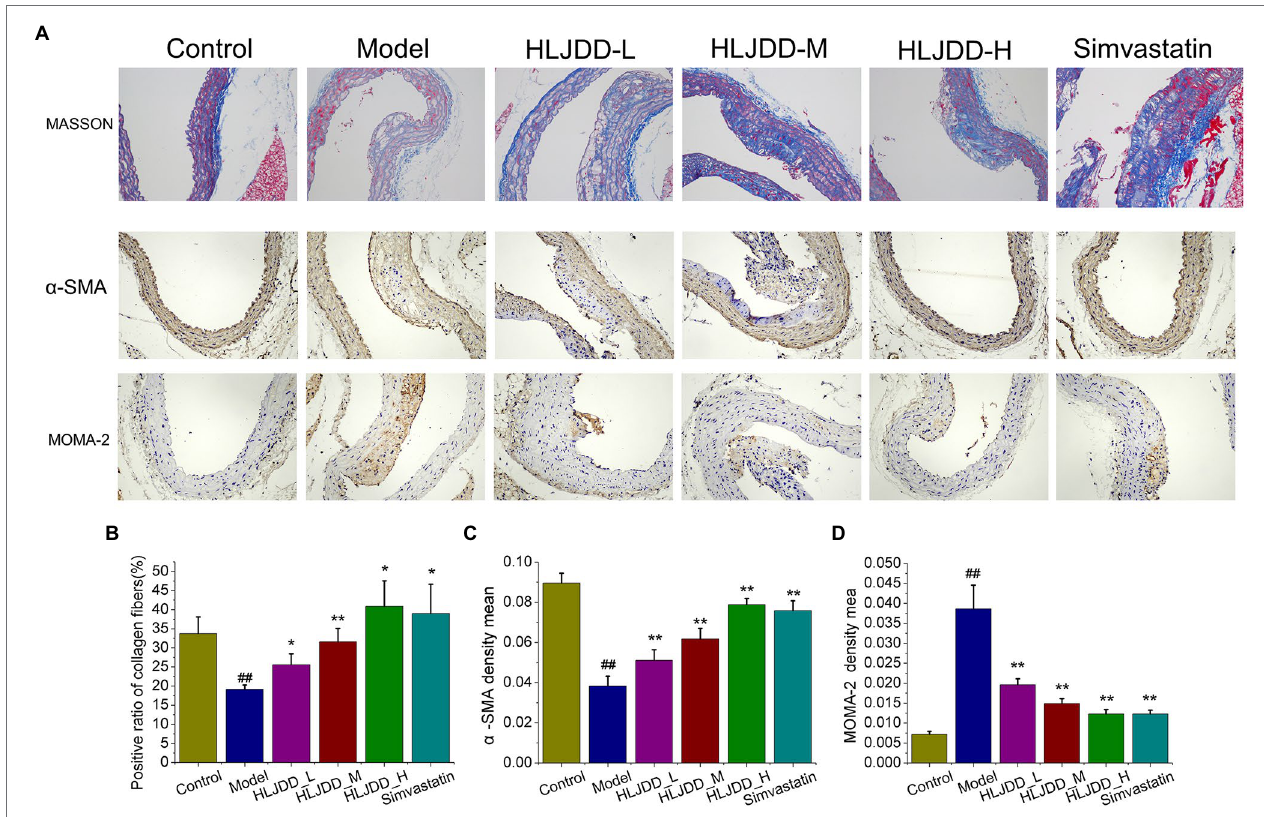
FIGURE 1 | Effects of Huang-Lian-Jie-Du decoction (HLJDD) on plaques stability of carotid lesion in ApoE − / − mice with atherosclerosis (AS). (A) Representative MASSON, immunohistochemical staining of α -SMA and MOMA-2 in carotid arteries sections are shown. Magnification, ×200; scale bar = 200 μ m. (B) The positive radio of collagen content in carotid sections by masson trichrome staining. Values are expressed as the mean ± SD. (C) The average optical density of α -SMA in carotid sections was semi quantitatively analyzed by Image Pro Plus 6.0 software. Values are expressed as the mean ± SD. (D) The average optical density (OD) of MOMA-2 in carotid sections was semi quantitatively analyzed by Image Pro Plus 6.0 software. Values are expressed as the mean ± SD ( n = 5; # p < 0.05 and ## p < 0.01 vs. the control group; * p < 0.05 and ** p < 0.01 vs. the model group; one-way